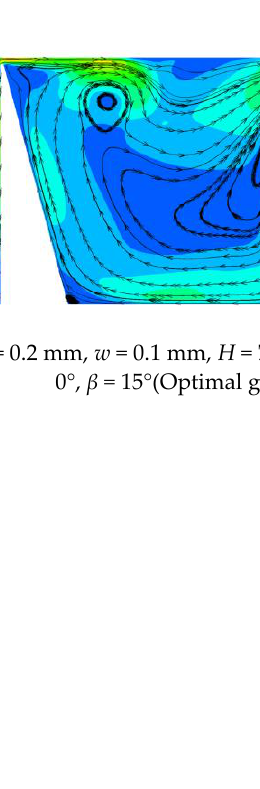
Figure 8. Variation of C d with iteration steps.